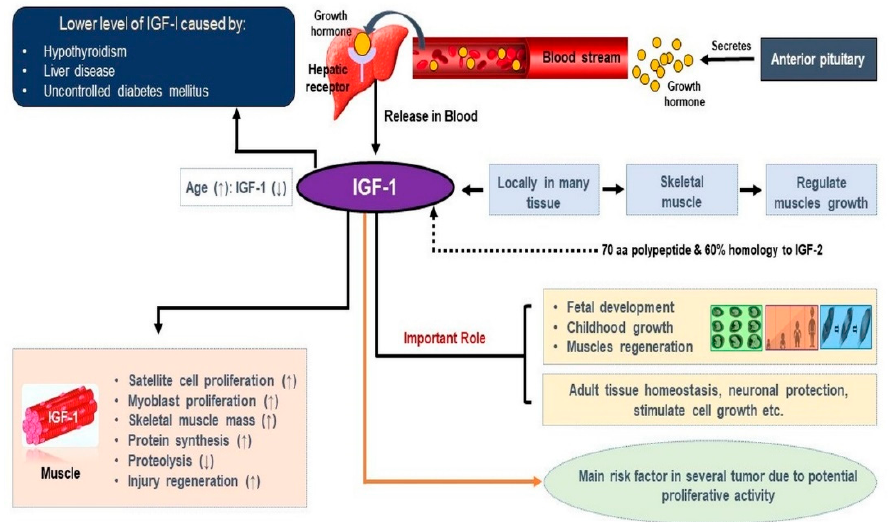
Figure 1. Role of insulin-like growth factor-1 (IGF-1) in skeletal muscle. IGF-1 is responsible for fetal development, child growth, and muscle regeneration, and elevated IGF-1 levels are required for muscle satellite cell (MSC) and myoblast proliferation, postinjury regeneration, and the increase of skeletal